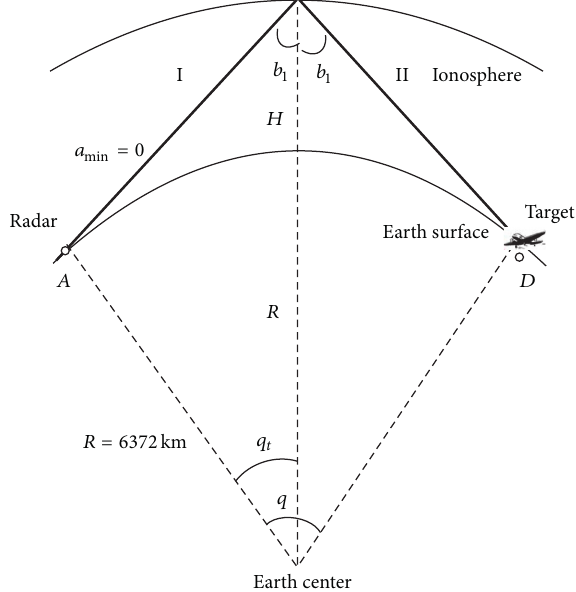
Figure 19: The illustration of the maximum detection range of the skywave